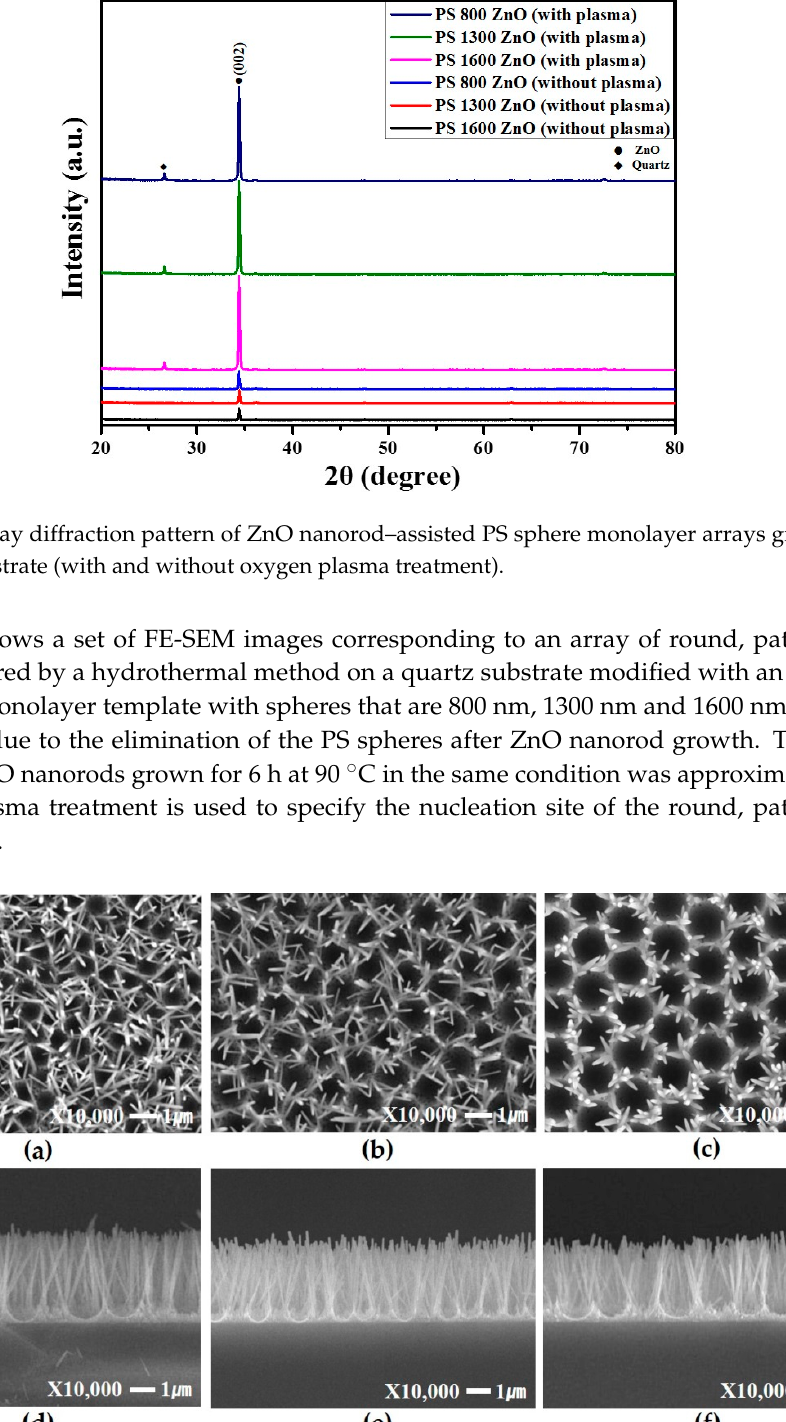
Figure 3. FE-SEM images of ZnO nanorod growth on quartz substrate using a PS monolayer template with oxygen plasma treatment. Diameters of polystyrene are ( a ) 800 nm; ( b ) 1300 nm; ( c ) 1600 nm and cross-section of ( d ) 800 nm; ( e ) 1300 nm and ( f ) 1600 nm, respectively.